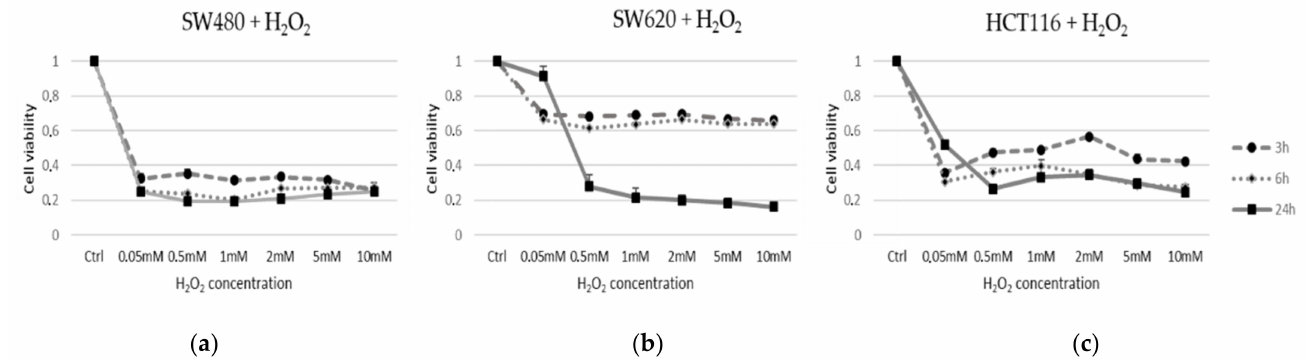
Figure 1. Cell line viability under acute oxidative distress condition. Cell viability was assayed using MTS Dye. ( a ) SW480 (MSS), ( b ) SW620 (MSS) and ( c ) HCT116 (MSI) cell lines were treated with H 2 O 2 at concentrations of 0.05; 0.5; 1; 2; 5; 10 mM and timing of 3 h, 6 h, 24 h. Cell viability values were calculated as means and compared to untreated starved cells